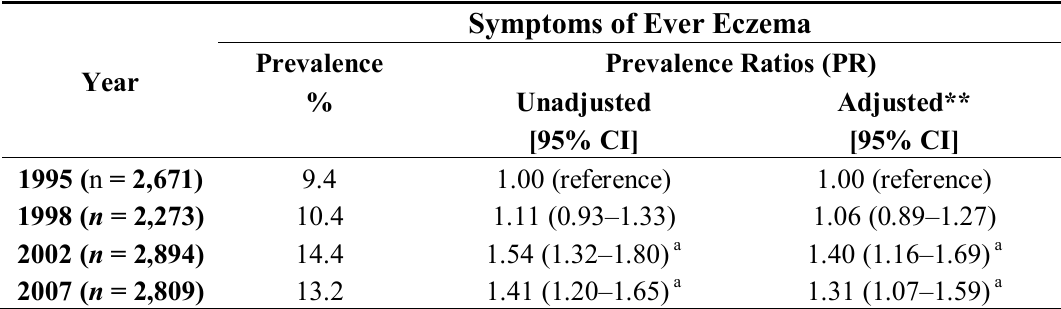
Table 2. Unadjusted and adjusted Prevalence Ratios (PR) of symptoms of ever eczema among Irish school children aged 13–14 years, 1995–2007 ( n =